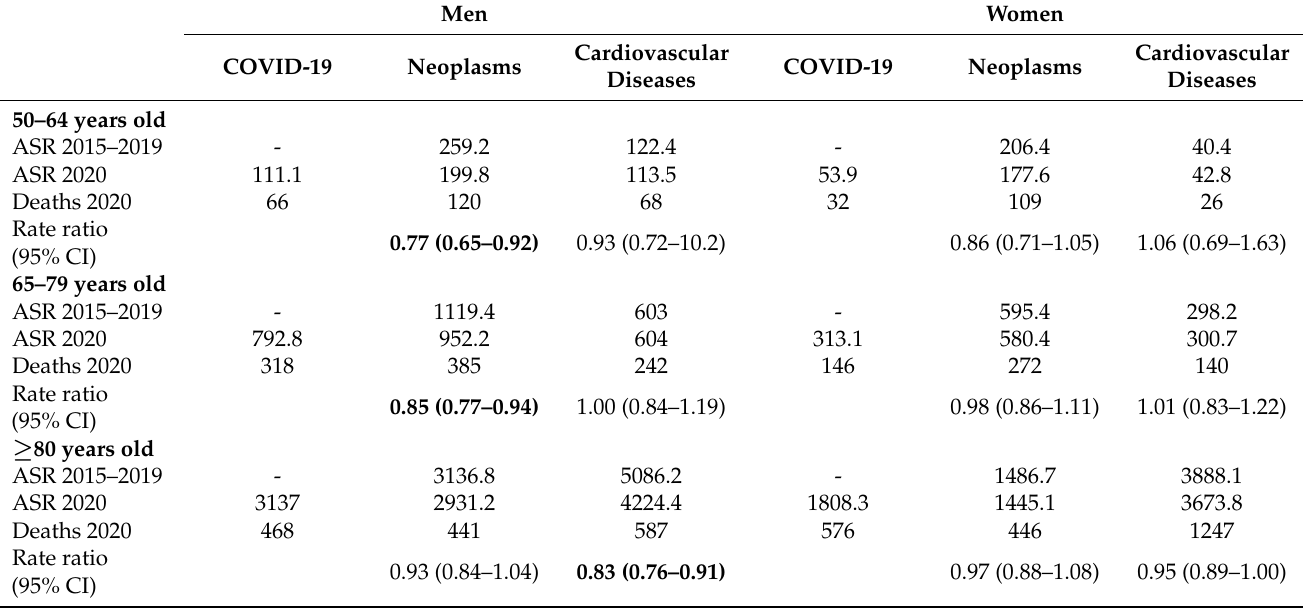
Table 3. Age-standardized 1 mortality rates (ASR) per 100,000 from COVID-19 diseases, neoplasms, and cardiovascular diseases, in 2015–2019 and 2020, number of deaths in 2020 and the rate ratio (2020 vs. 2015–2019) with the corresponding 95% confidence interval (CI), according to sex and age groups. Province of Pavia, Italy. Men Women Cardiovascular Cardiovascular Neoplasms COVID-19 Neoplasms Diseases